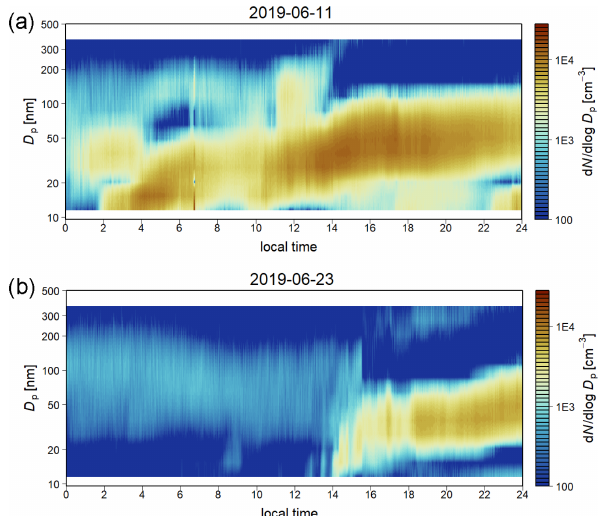
Figure 7. Time series plots of the aerosol number size distribu- tion of aerosol particles on exemplary days at (a) Eagle Lake and (b) Nazko